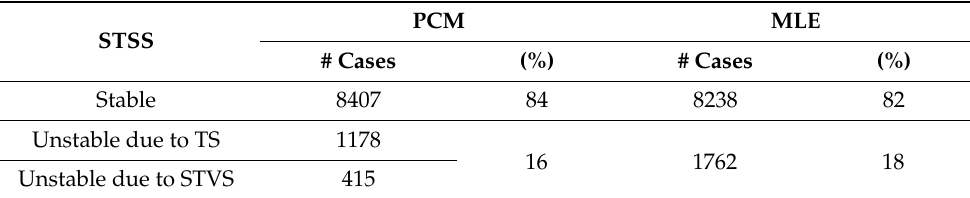
Table 4. STSS assessment results based on MLE and